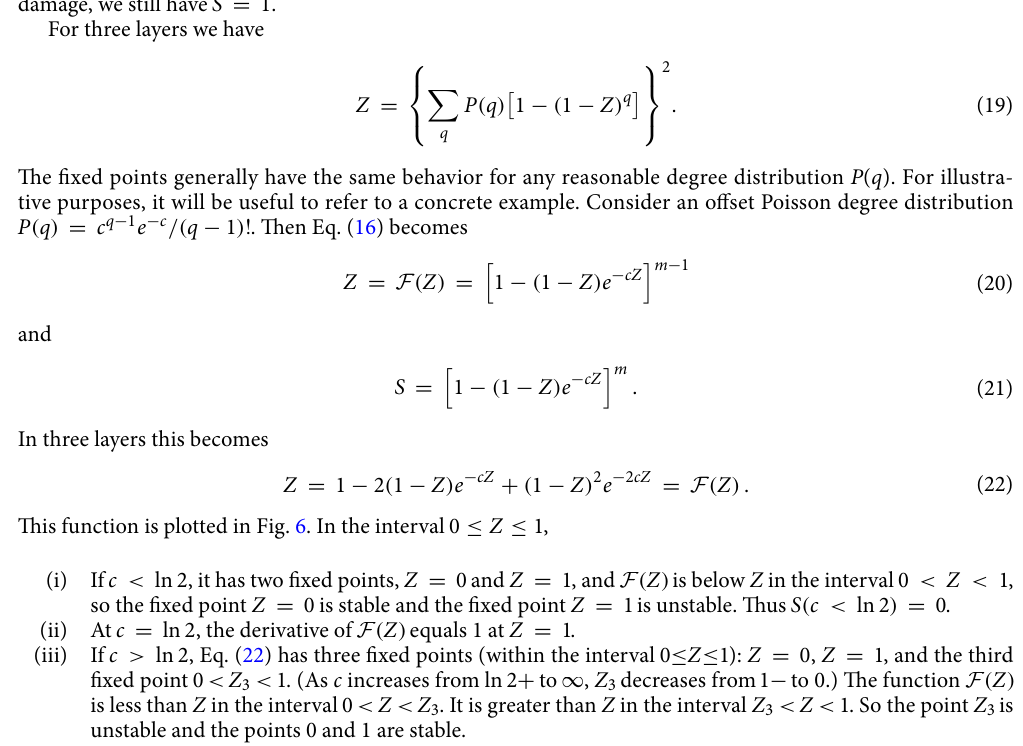
Figure 6. Function F ( Z ) for symmetric uncorrelated offset Poisson degree distribution, 1 ) 0 . The network is undamaged, and Z P ( q ) e − c c q − 1 /( q for q > 0 , and P ( 0 ) = − ! = 2 layers the fixed point is stable for any c > 0 . In m point. ( a ) In m = ln 2 . Panel ( b ) shows a profile of F ( Z ) in the unstable phase for 1 / 2 , corresponding to c happens at P ( 1 ) = = ln 2 , and ( d ) the stable phase for c > ln 2 c < ln 2 , ( c ) represents the critical point c =